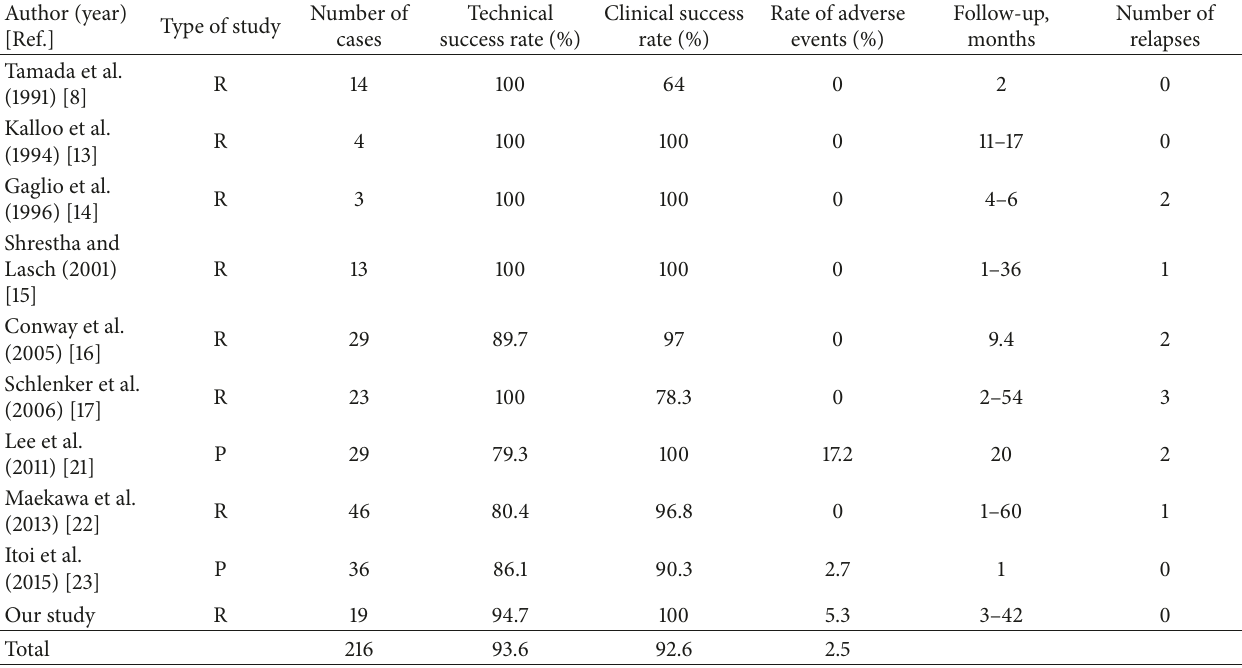
Table 3: Published outcomes of endoscopic transpapillary gallbladder